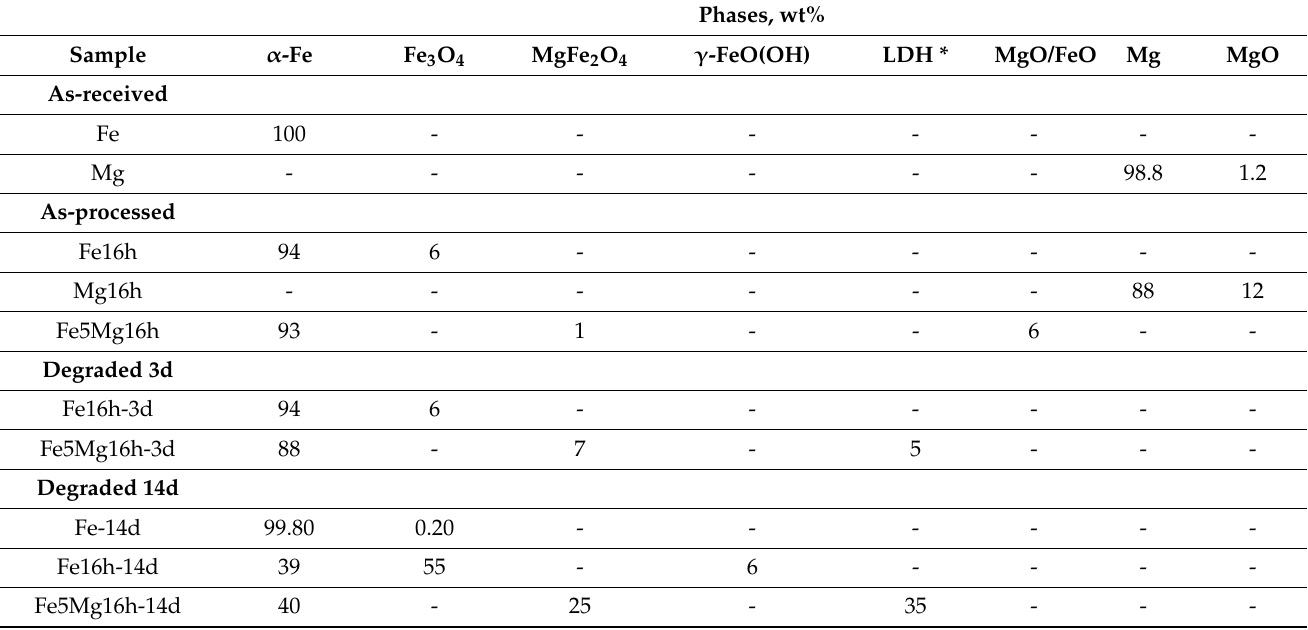
Table 2. Proportion of phases (wt%) resulting from Rietveld analysis of as-processed and degraded Fe, Fe16h, and Fe5Mg16h powders for 3 and 14